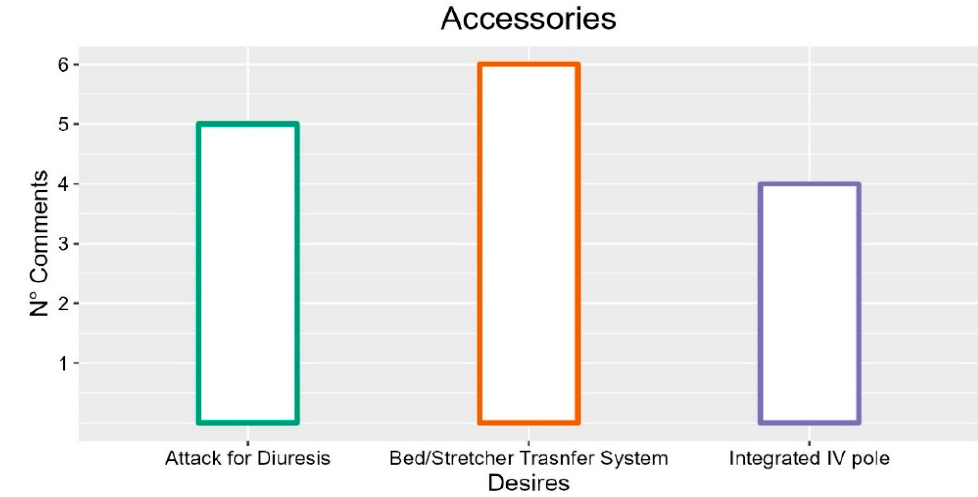
Figure 6. Graphical representation of desires with more occurrences for the Accessories theme.